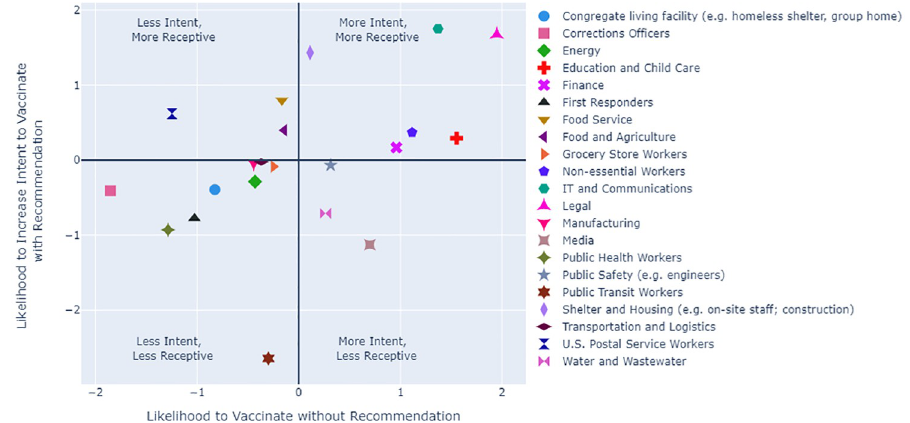
Fig 1. Likelihood to vaccinate vs change in vaccine intent with healthcare professional vaccine recommendation for essential worker classes.